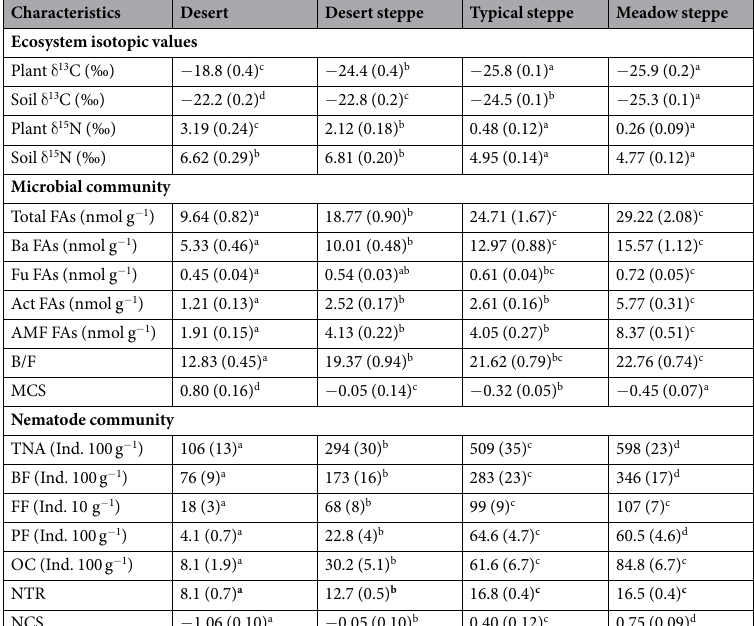
Table 1. Characteristics of ecosystem isotopic values, soil microbes, and nematodes of the four vegetation types in the Mongolian grassland. Values are means (SE). Different letters in a row indicate significant differences among the four vegetation types (one-way ANOVA, P < 0.05). Microbial community: FAs, phospholipid fatty acid; Ba FAs, bacterial FAs; Fu FAs, fungal FAs; Act FAs, actinobacterial FAs; AMF FAs, arbuscular mycorrhizal fungal FAs; B/F, ratio of bacterial FAs to fungal FAs; MCS, microbial community structure; Nematode community: TNA, total nematode abundance; BF, bacterial-feeding nematodes; FF, fungal-feeding nematodes; PF, plant-feeding nematodes; OC, omnivore + carnivore nematodes; NTR, nematode taxon richness; NCS, nematode community